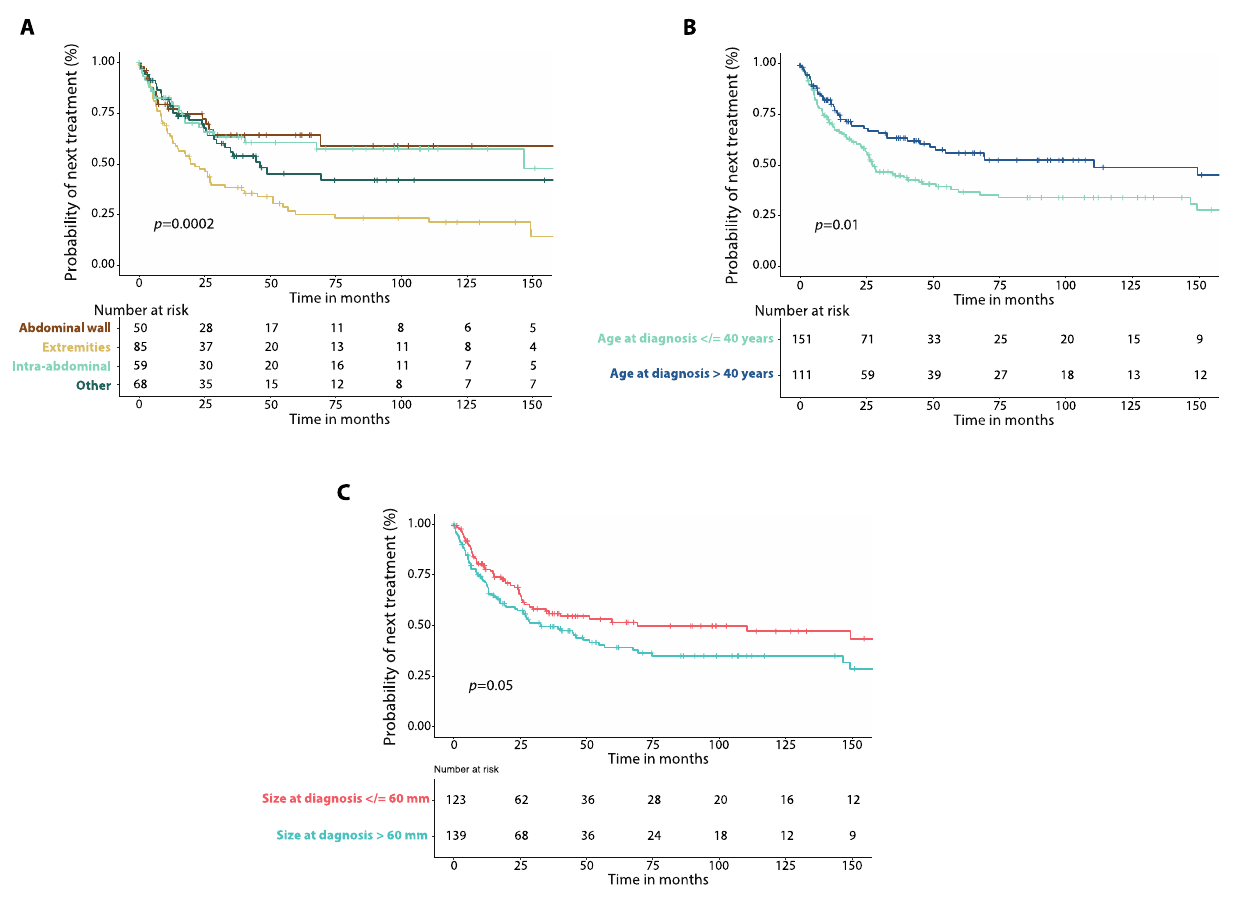
Figure 4. ( A ) Kaplan–Meier curves show time to next treatment (TTNT) after first ‐ line therapy in patients with intra ‐ abdominal desmoid tumors (DTs) compared to those of the extremities, of the abdominal wall and those affecting other locations. ( B ) Kaplan–Meier curves show time to next treatment (TTNT) in patients with DTs and age at diagnosis equal to or lower than 40 years com ‐ pared to those with age at diagnosis greater than 40 years. ( C ) Kaplan–Meier curves show time to next treatment (TTNT) in patients with DTs and size of tumor at diagnosis equal to or smaller than 60 mm compared to patients with tumor size greater than 60 mm. p ‐ values were calculated with the Log ‐ Rank method.